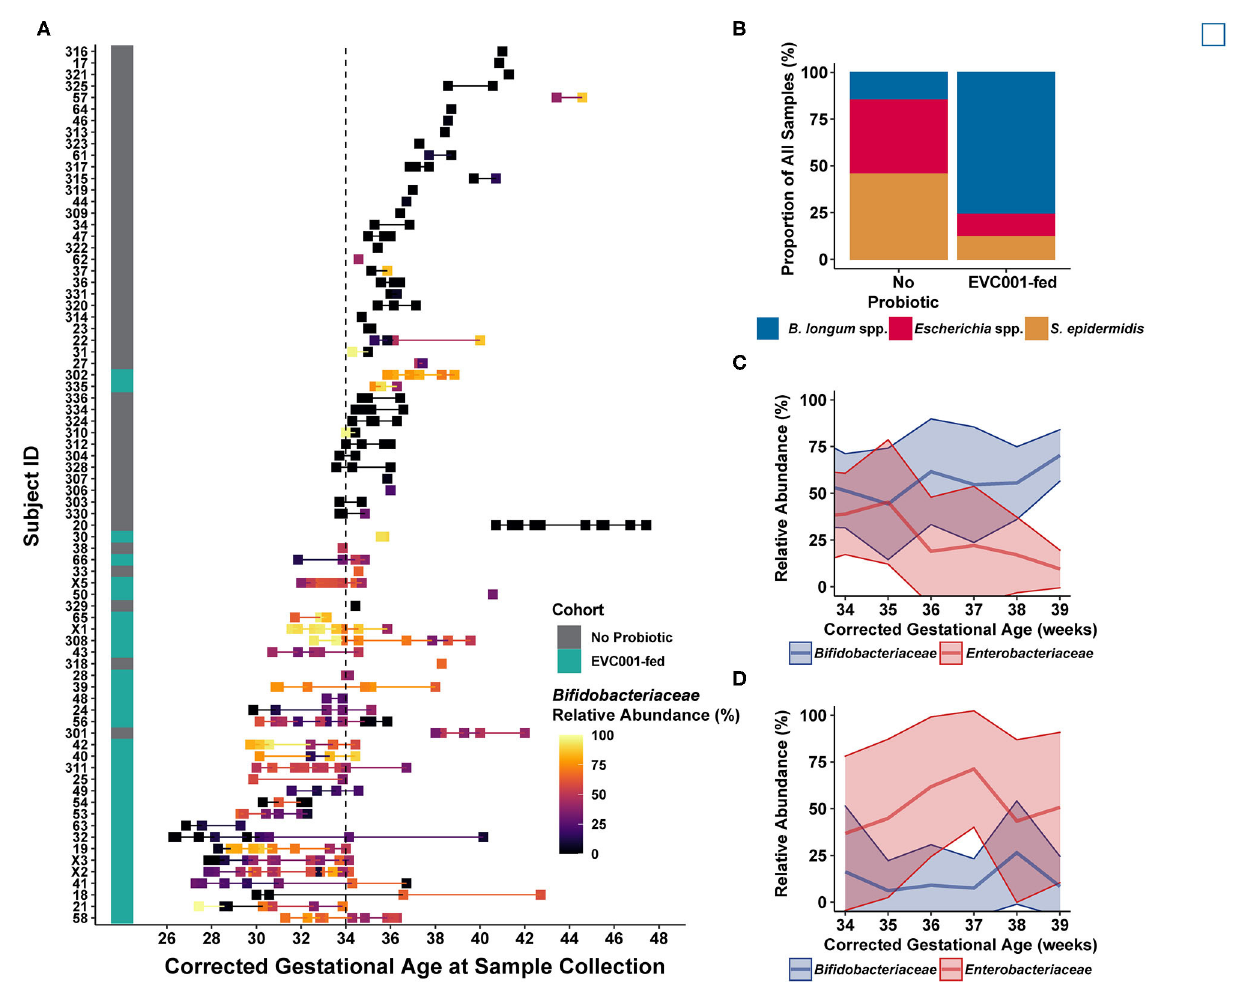
FIGURE 3 | Infant fecal samples collected over time reflect feeding protocols and improved development trajectories with B. infantis EVC001. (A) Infant fecal samples (squares) collected over time, arranged by individual patient (y-axis) and corrected gestational age at sample collection, and ordered by gestational age of the infant at birth (from earliest gestational age at birth, bottom, to oldest gestational age at birth, top) and shaded by the abundance of Bifidobacteriaceae (see color scale). Infant feeding protocol is denoted by the teal (EVC001-fed) or gray box (No Probiotic). Note that the feeding protocol assignment is based both on gestational age at birth and birth weight, so some subjects (e.g., 302, 335) were assigned to the probiotic feeding protocol based on weight at birth (i.e., < 1500g). (B) Fecal sample composition was clustered by species-level signature taxa (e.g., B longum species, Escherichia coli and unclassified Escherichia , and S. epidermidis ), as indicated by color. Infants in the EVC001-fed feeding protocol more frequently developed a gut microbiome composed of primarily B. longum species (blue), while the infants not assigned to receive the probiotic frequently had compositions typified by high levels of Enterobacteriaceae (e.g., Escherichia species) and/or Staphylococcus (red and orange, respectively). (C) Over time, infants fed B. infantis EVC001 developed a high mean abundance of Bifidobacteriaceae (blue line) which increased as infants approached term gestational age, and this was negatively associated with the abundance of Enterobacteriaceae (red line). (D) In contrast, among infants not fed B. infantis EVC001, the abundance of Enterobacteriaceae did not change as infants approached term gestational